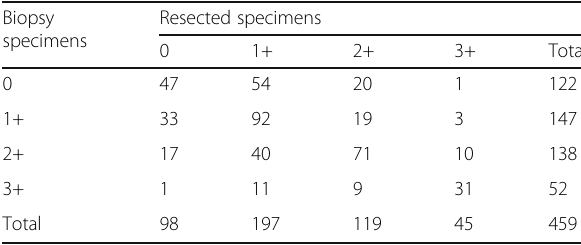
Table 5 IHC status of HER2 in paired biopsy and resected